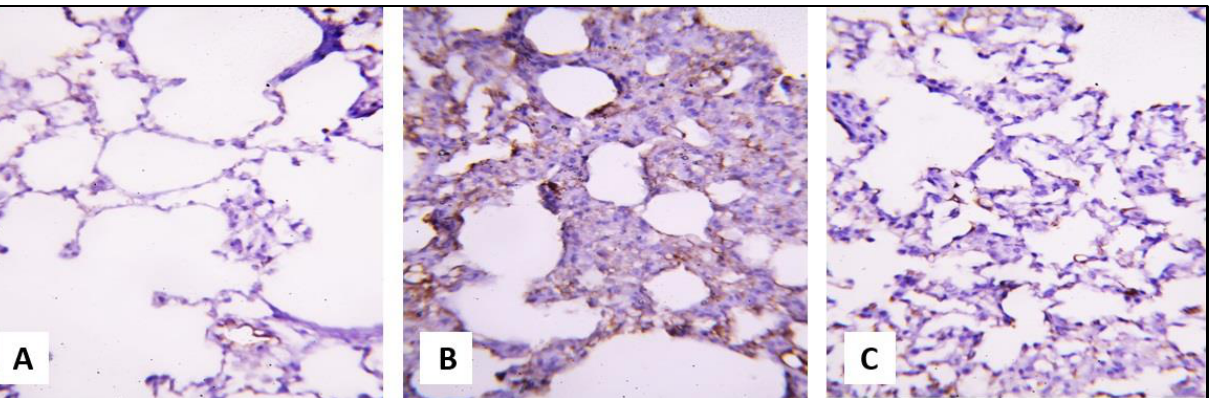
Figure 8. A section of rat lung showing the following features. ( A ) A weakly positive brown cyto- plasm reaction along the alveolar epithelial lining of the control group (caspase-3 immunostaining, ×400). ( B ) A dense, positive brown cytoplasmic reaction in the exfoliated cells and interstitial inflam- matory cells (black arrow) of group II (caspase-3 immunostaining, ×400). ( C ) A weakly positive brown cytoplasm reaction in the alveolar epithelial lining of group III (caspase-3 immunostaining, ×400). The apparent rise in PAS-positive cells in the large bronchial passage lining relative to the control was noticed in group II PAS-stained sections (Figure 9).